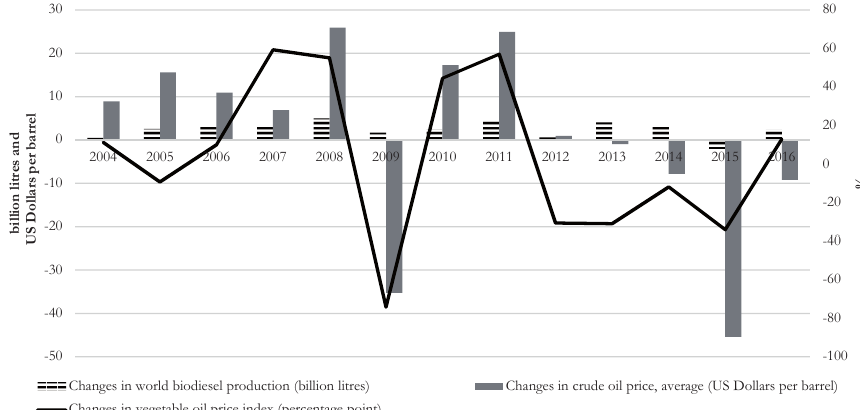
Fig. 7 – Changes in biodiesel production, crude oil price and vegetable oil price index (2003-2016). Source: OECD/FAO (2017b), FAO (2016), World Bank